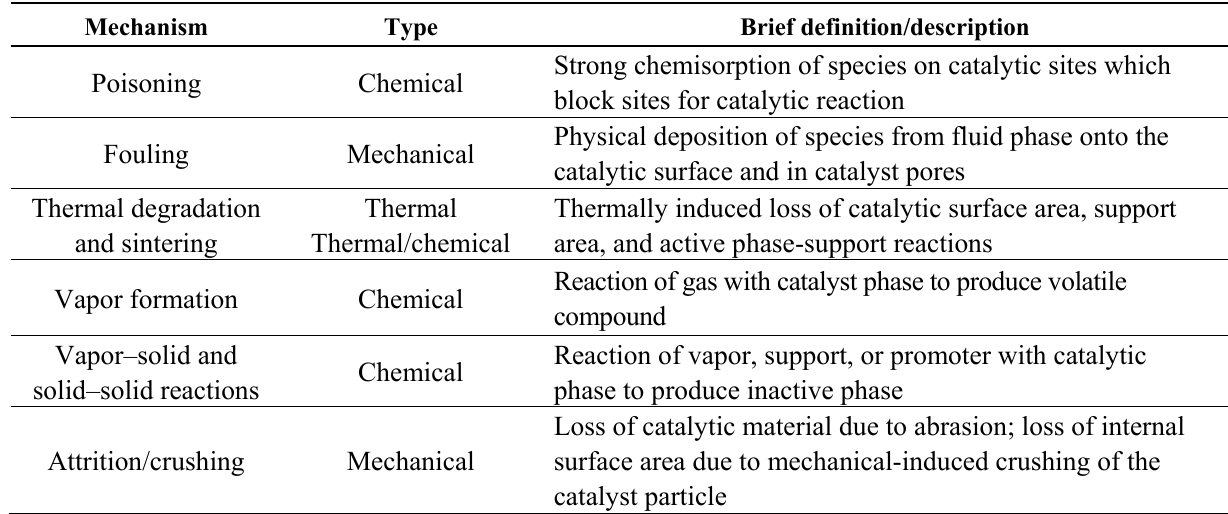
Table 1. Mechanisms of catalyst